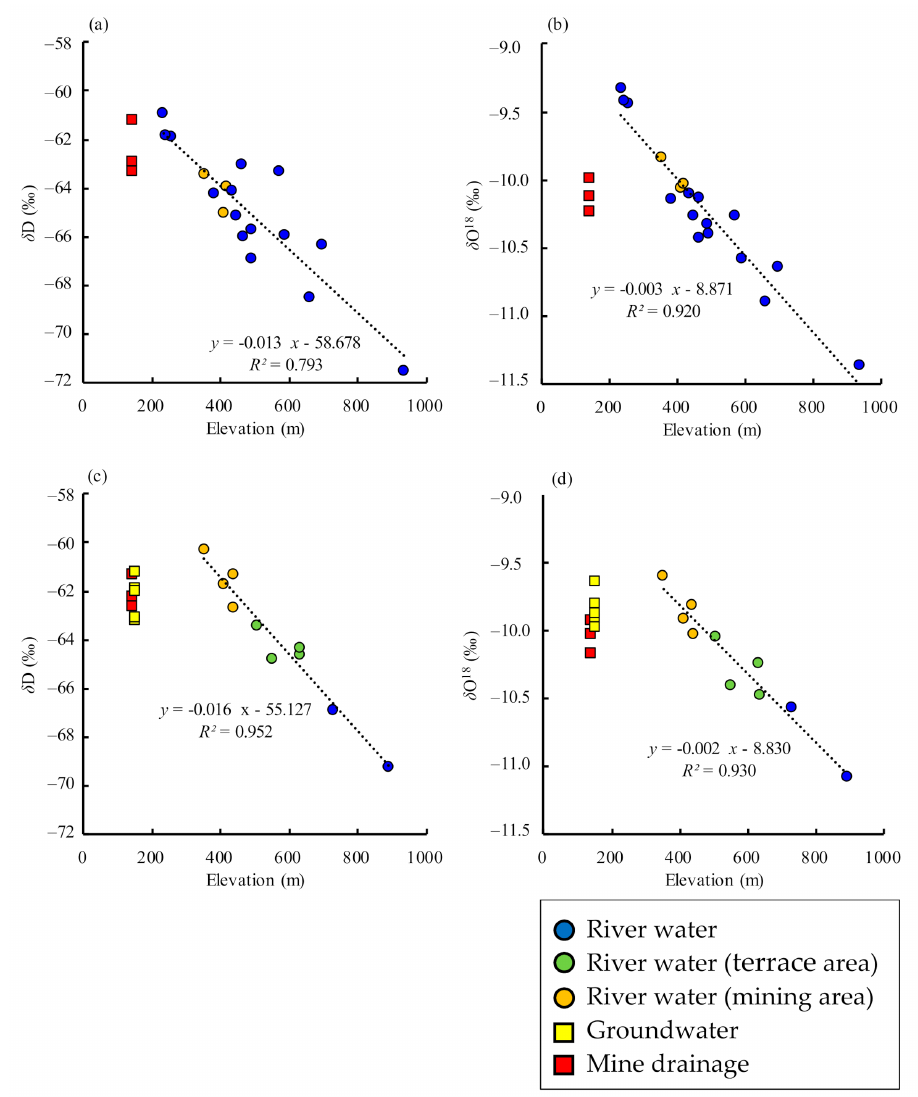
Figure 5. Relationship between the elevation of river catchment areas and stable-isotope ratios, including regression lines. ( a ) September 2020, δ D; ( b ) September 2020, δ 18 O; ( c ) December 2020, δ D; ( d ) December 2020, δ 18 O. The elevation of the river catchment area was calculated by averaging the elevations of the water sampling site and the most upstream